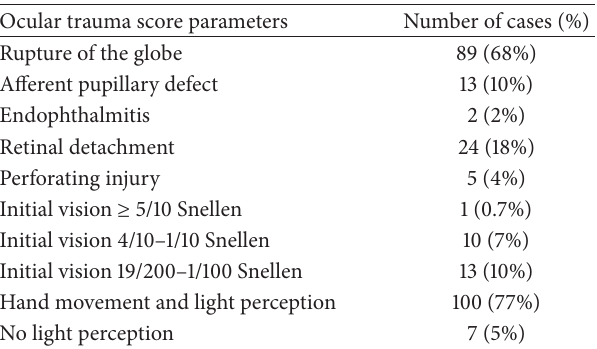
Table 2: Thirteen independent variables evaluated among one- hundred thirty-one open globe